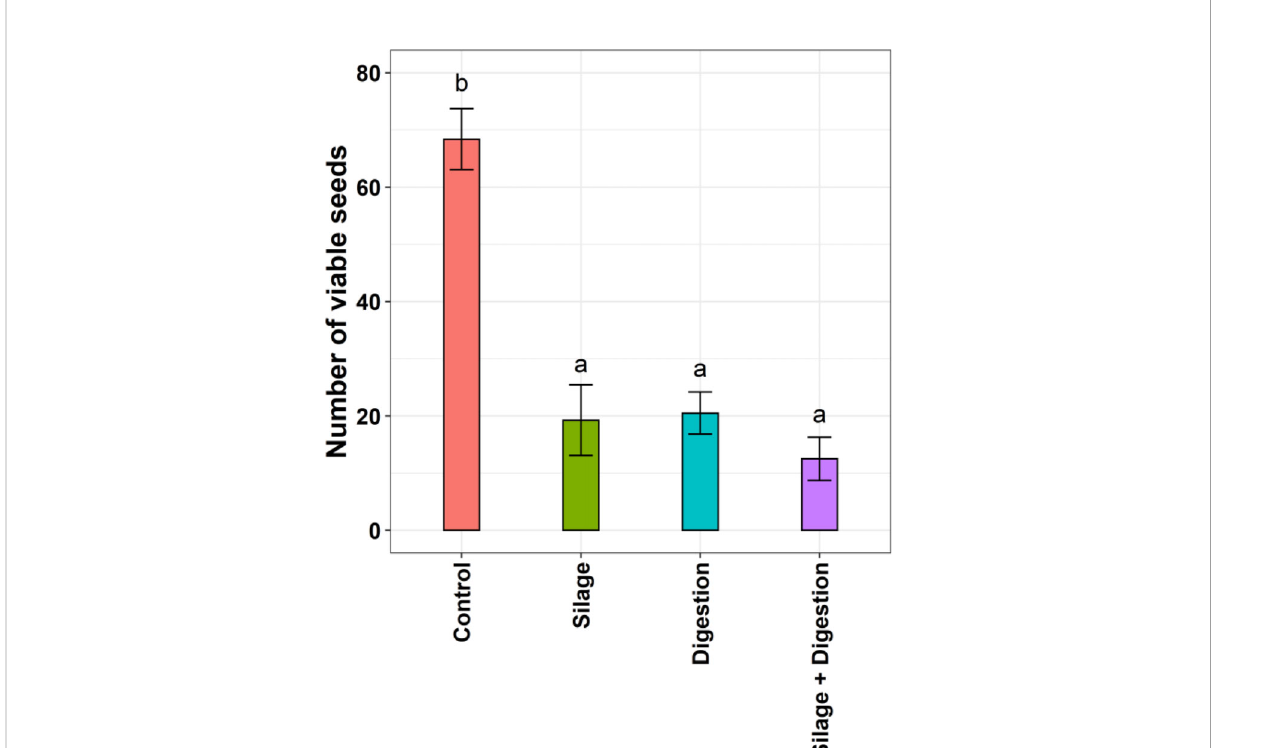
FIGURE 1 Average seed viability of four populations of feathertop Rhodes grass in response to different seed treatments in 2021. Vertical bar shows mean (± standard error) of germination. Different letters show signi fi cant difference as identi fi ed by Tukey ’ s HSD at p <0.05.